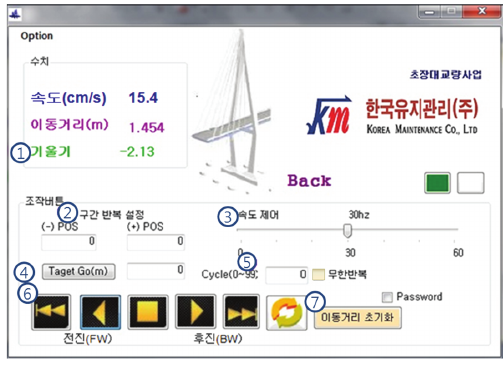
Functions of robot control software Robot status (velocity, location, and inclination) Measuring range